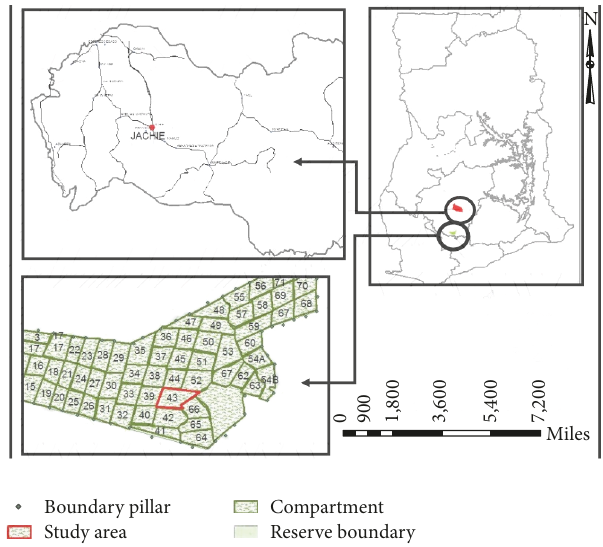
Figure 1: Map of Ghana showing the locations of Jachie community and compartment 43 of Nkrabea forest reserve.